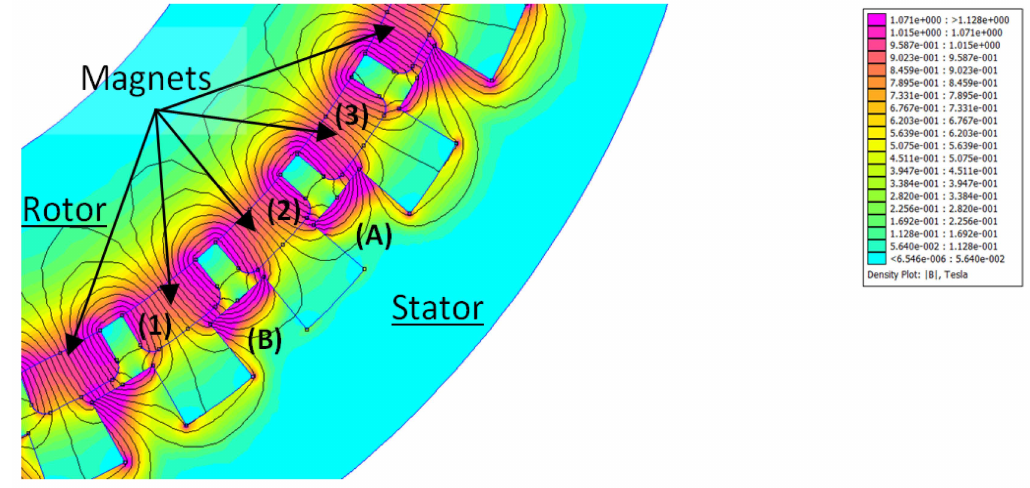
Figure 14. In this partial view of a machine having 40 poles and 36 slots; it appears that the magnetic flux in the top of the teeth (A and B) will never be zero. When the magnets of the rotor (1, 2 or 3) are not in front of the tooth, the tooth is acting as a magnetic short